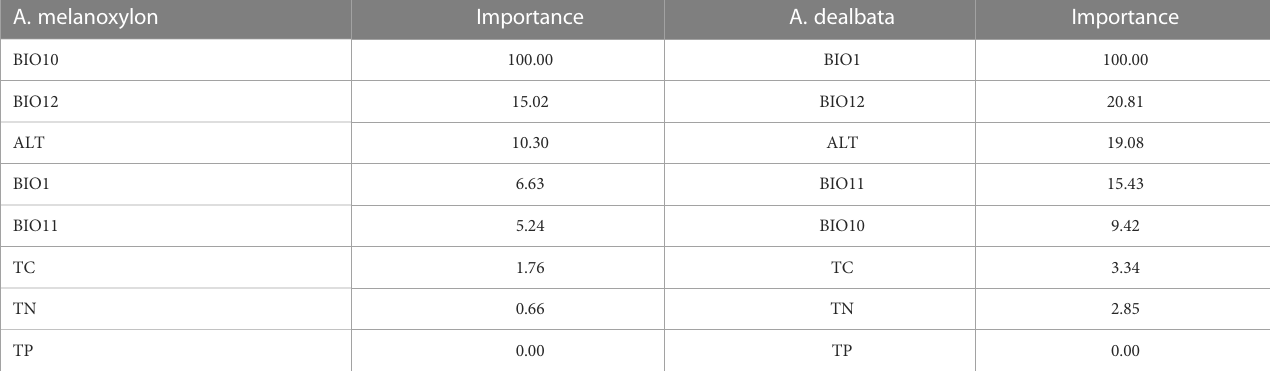
TABLE 3 Relative importance of variables on SDMs for A melanoxylon and A. dealbata . Importance is expressed as the mean decrease Gini index.